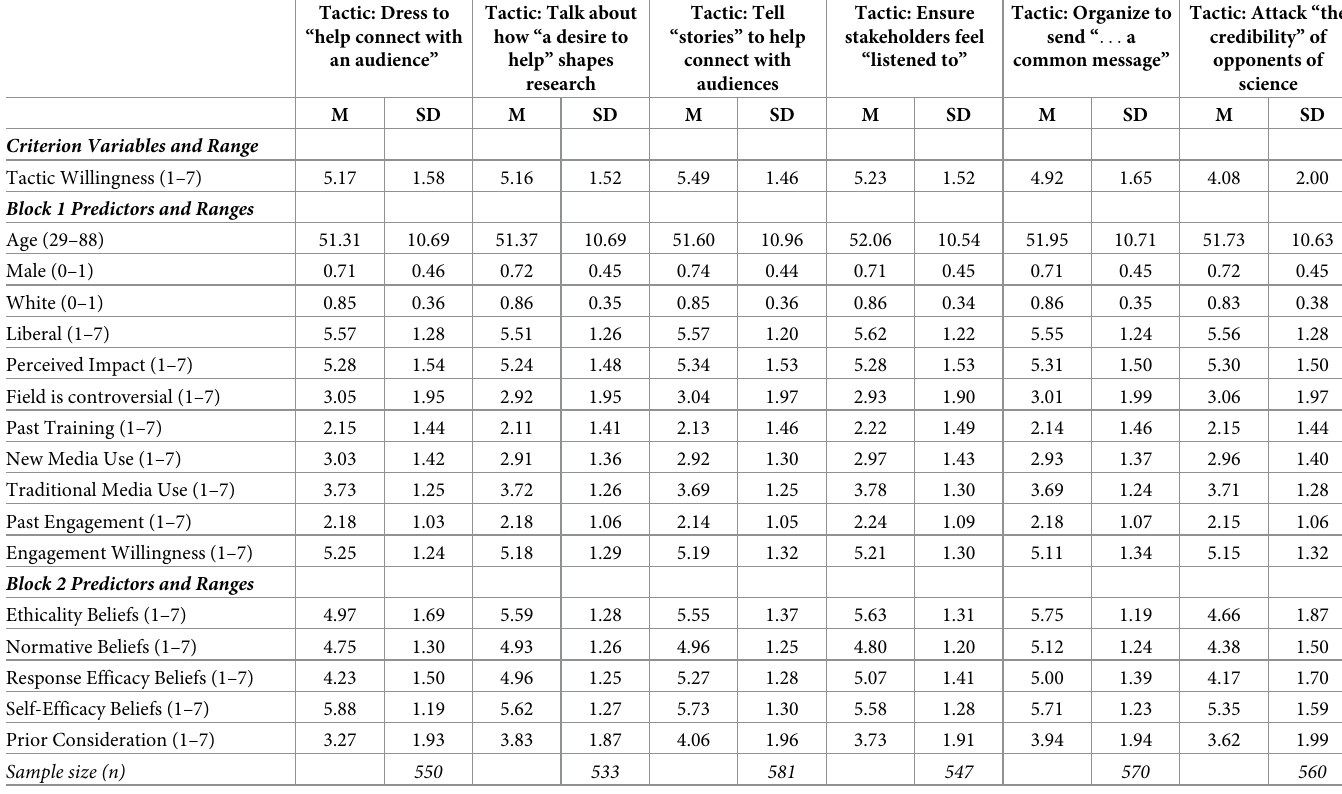
Table 1. Descriptive statistics for all variables used in analyses by tactic